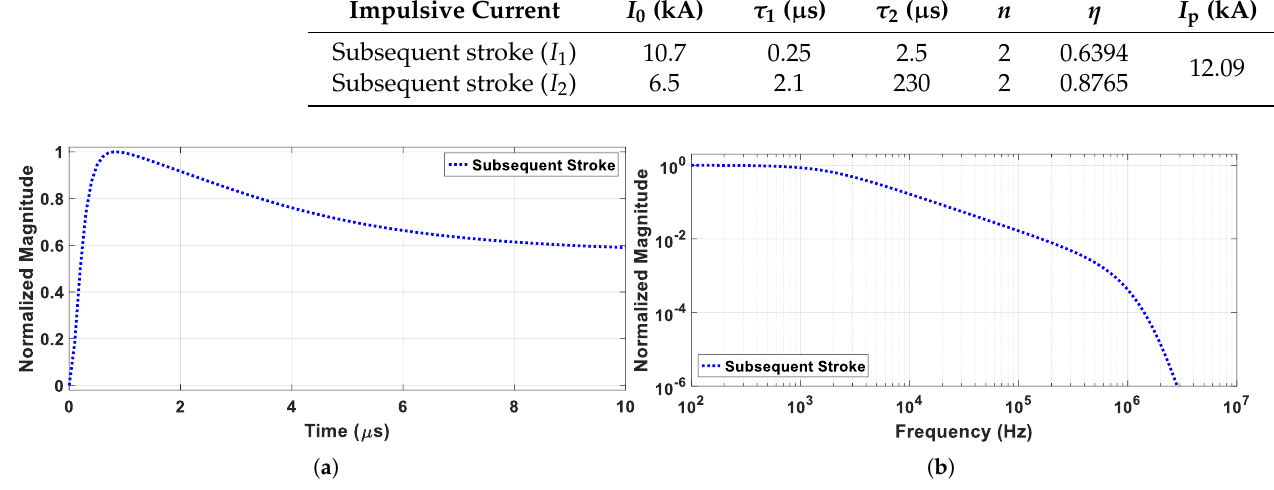
Figure 3. Lightning current modeled as a subsequent return stroke: ( a ) Time-domain normalized waveform and ( b ) Frequency-domain normalized spectrum.